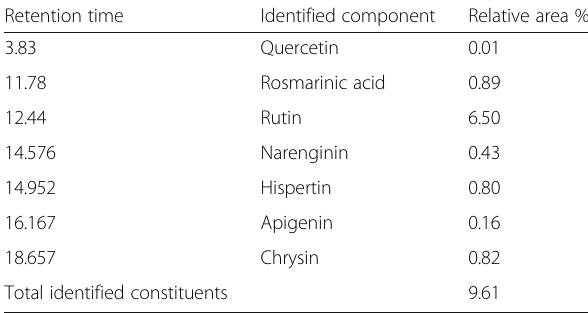
Table 3 RP-HPLC analysis of phenolics components of C. azarolus var. eu- azarolus leaves extract at λ = 330 nm Retention time